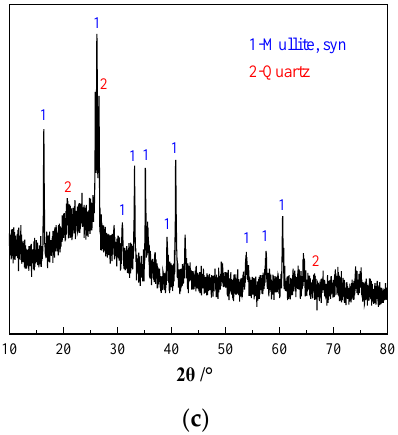
Figure 4. Analysis of ultrafine fly ash (UFA). ( a ) Particle size analysis; ( b ) SEM image; ( c ) XRD pattern.